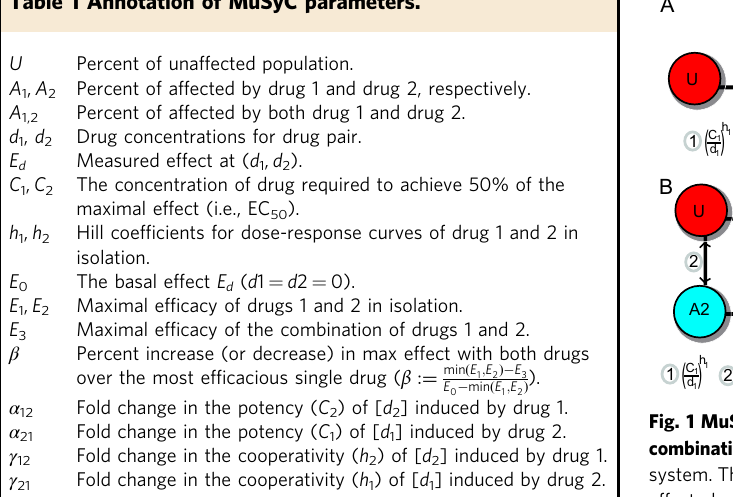
Table 1 Annotation of MuSyC